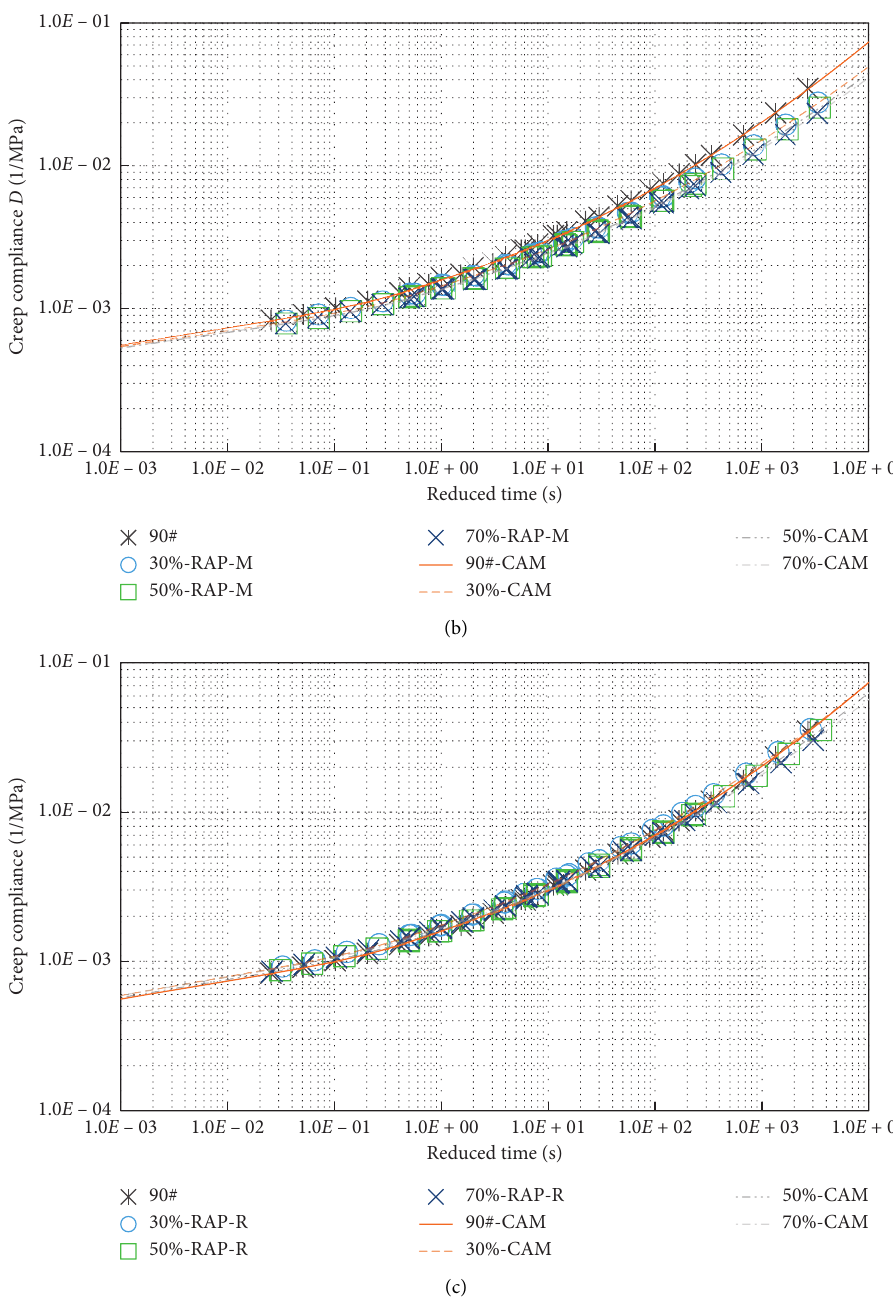
Figure 14: Master curves from the CAM model for BBR data of three types of recycled binders. (a) Control binder, (b) RAP-M binder, and (c) RAP-M